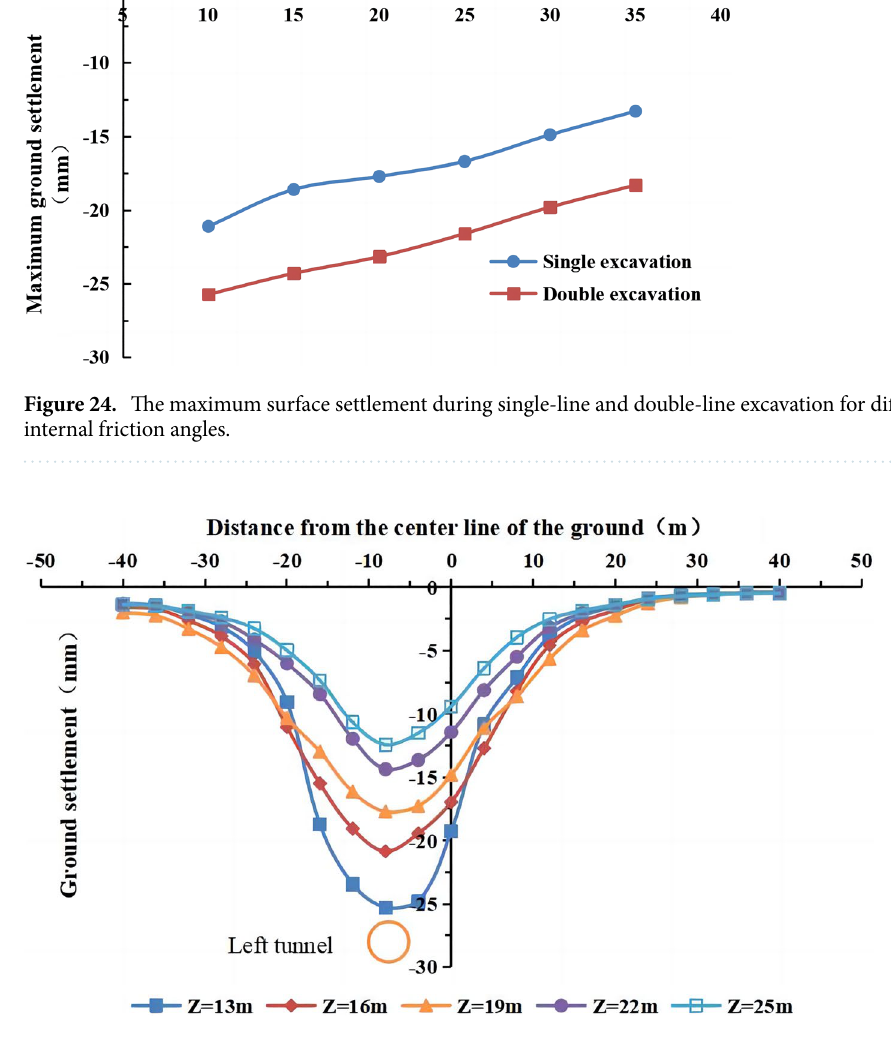
Figure 28 indicates that the surface settlement decreases as the thrust of the shield machine increases from 170 to 560 kPa. The maximum surface settlement decreases from 17.4 to 5.2 mm during single-line excavation and from 28.4 mm to 13.1 during double-line excavation. When the shield tunneling pressure is 690 kPa, there is no need to maintain the balance between the earth pressure of the shield machine and the earth pressure of the excavation face. The soil exhibits large deformation. The ground surface in front of the shield machine rises locally. After the shield machine passes, the ground surface begins to settle and stabilizes. The double-line tunnel shield machine results in a significant ground disturbance. Therefore, a significant change in the surface settlement is observed at a thrust of 690 kPa, and the effect is more pronounced for the double-line excavation. Figure 29 shows that a high thrust causes surface uplift in the initial stage of the left-line excavation, which is consistent with the actual results. After the excavation of the right line has started, a high thrust accelerates the increase in surface settlement. Thus, a suitable thrust should be chosen to reduce surface settlement. During the construction of the double-line tunnel, the shield machine significantly disturbs the stratum, especially in the middle of the left and right tunnels. Therefore, excessive thrust results in surface uplift and may cause greater surface settlement during double-line construction. The influence of the shield grouting quality on surface settlement. Many factors affect the grouting quality, such as the ratio of the grouting liquid, the grouting pressure, and the grouting duration time. In this numerical simu- lation, the deformation modulus of the grouting layer is used as a proxy of the grouting quality. The deformation modulus of the grouting layer was E = 0.17 MPa, 1.7 MPa, and 17 MPa in the numerical simulation. The settle- ment values at the monitoring point of the profile at y = 50 m are shown in Fig. 30 and Fig. 31.